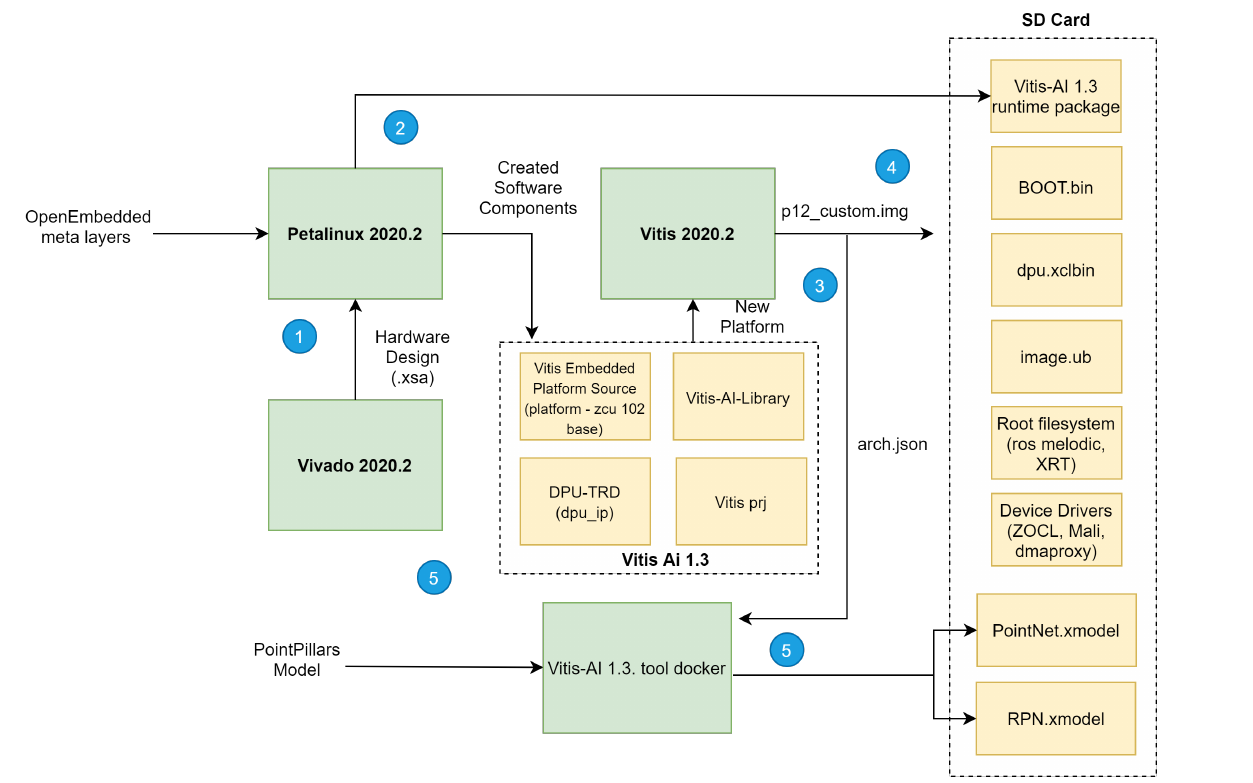
Figure 4. Hardware and Software implementation flow for